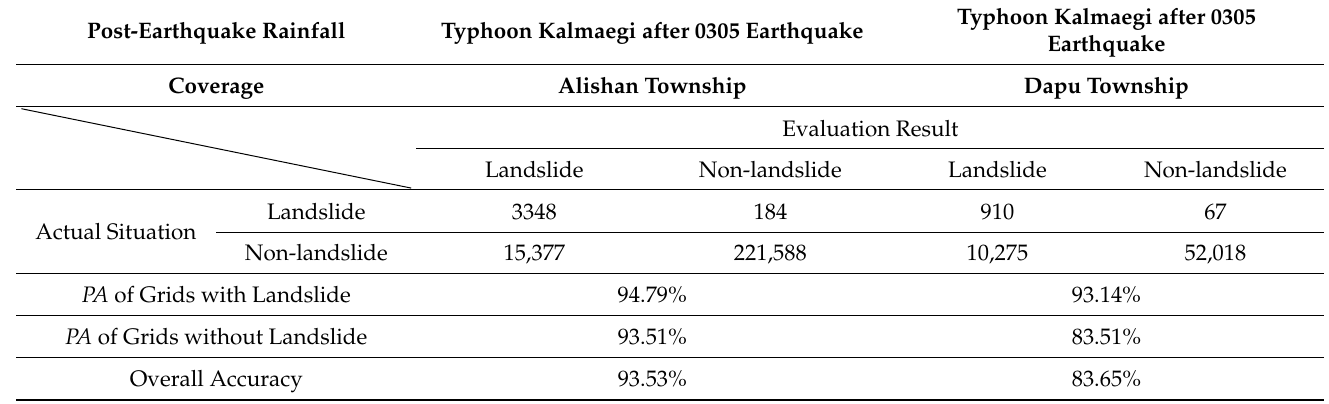
Table 11. Evaluation accuracy of postearthquake rainfall-induced landslide